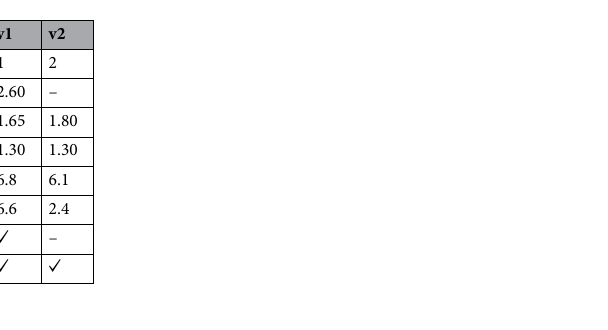
Table 1. Needle design